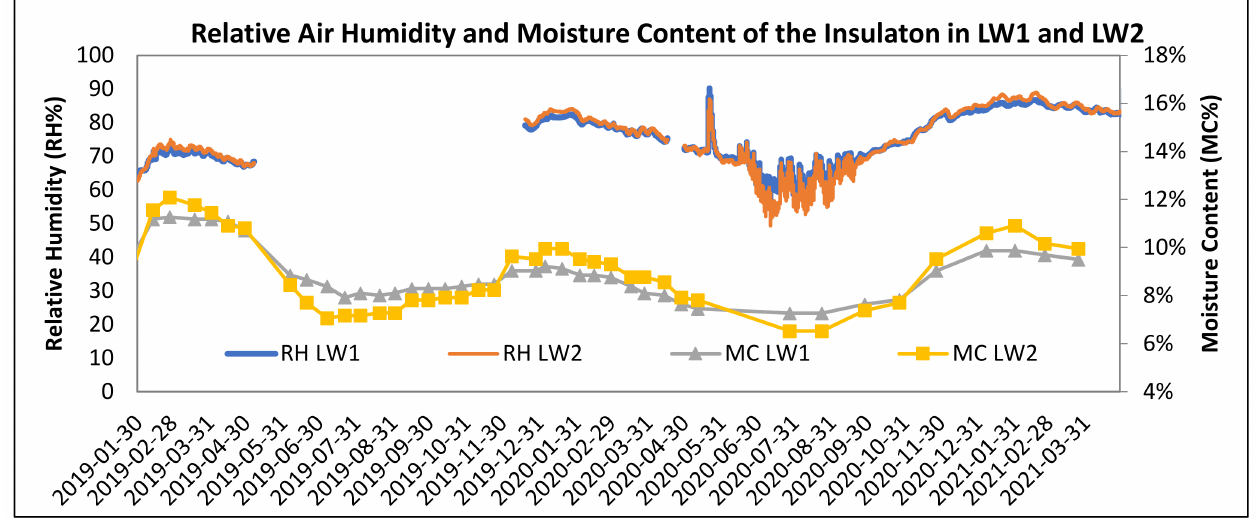
Figure 17. The Moisture Content of the Fiberboard Insulation STEICO Flex part 3 between Studs and Recorded Relative Air Humidity in the Walls.